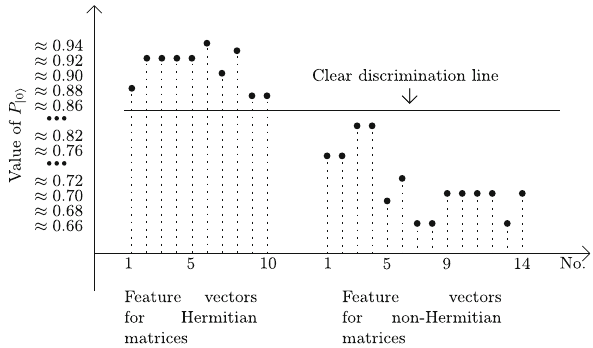
Fig.4 DiscriminationlineforvaluesofprobabilityforthekNNmethod when matrices are encoded with feature